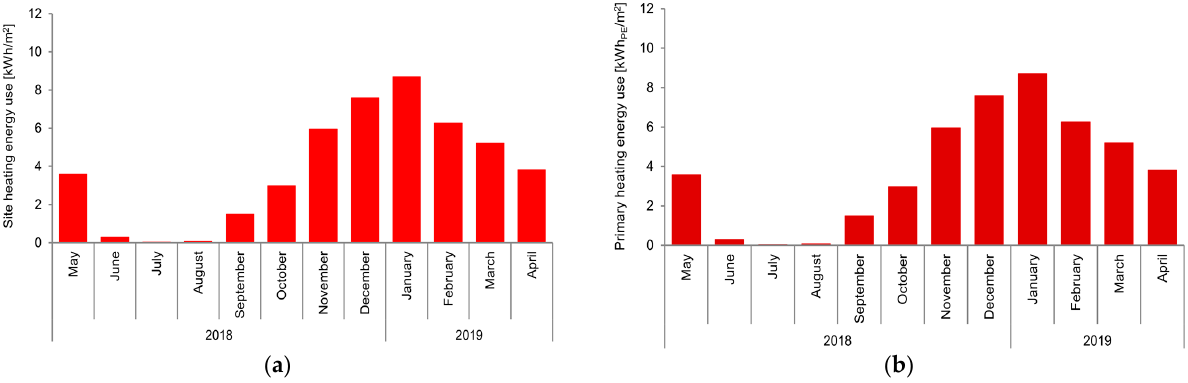
Figure 9. Total monthly natural gas use from May 2018 to April 2019 for space heating: ( a ) site heating energy use (kWh/m 2 ); ( b ) primary heating energy use (kWh PE /m 2 ).